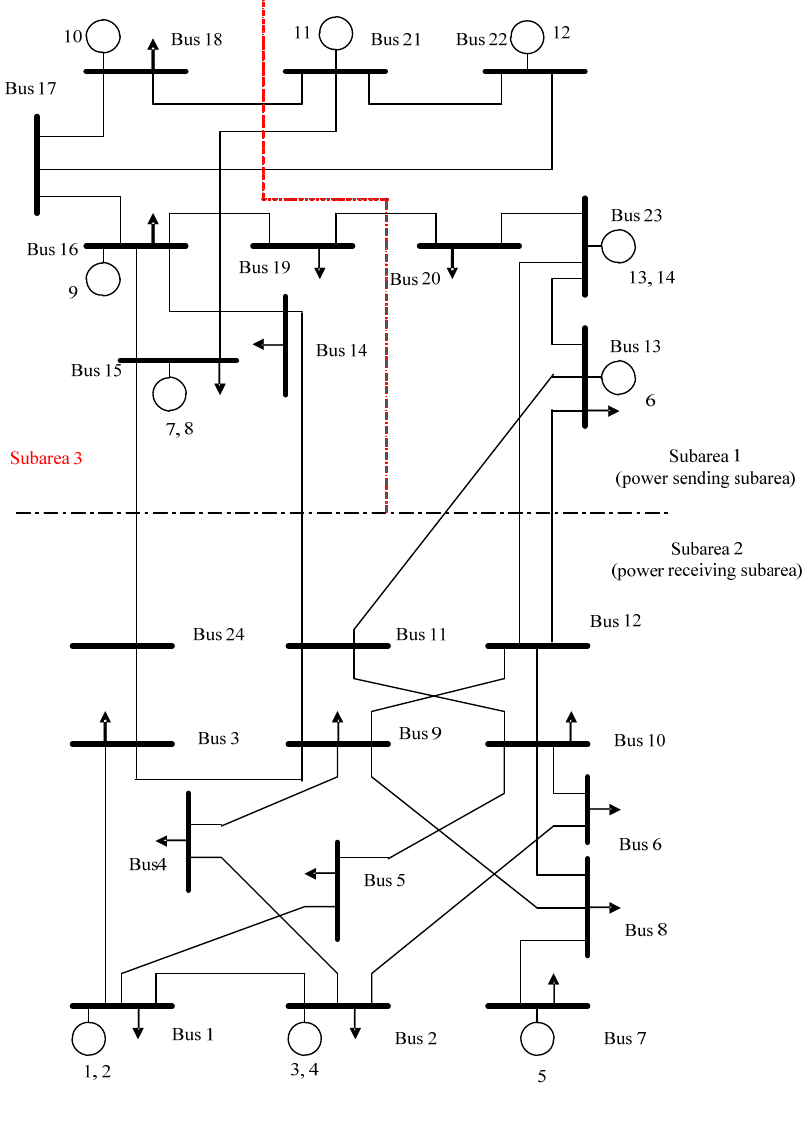
Figure A1. IEEE RTS system with two/three sub-area